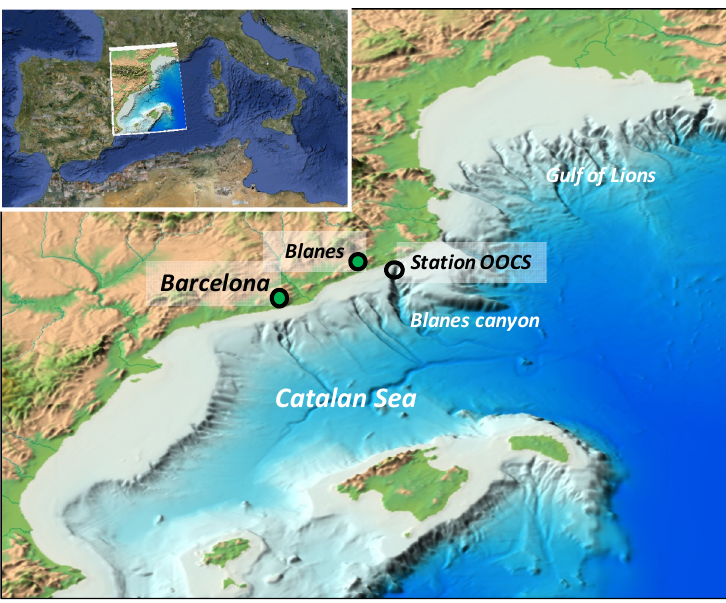
Figure 1. OOCS location in the Catalan Sea (western Mediterranean). The source of the Catalano-Balearic Sea-Bathymetric chart map is: